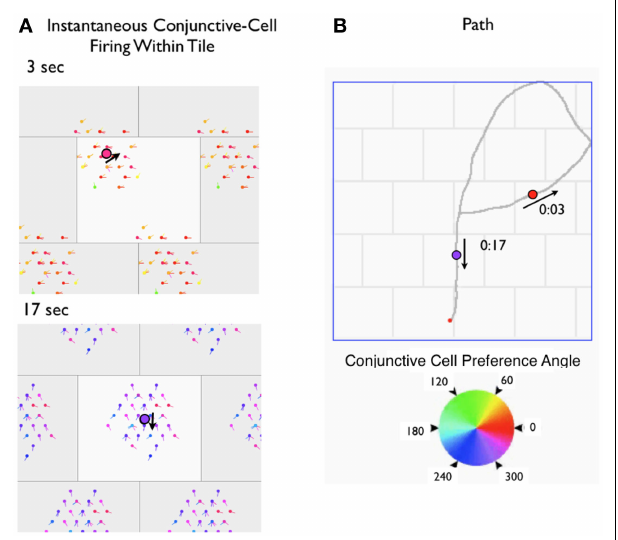
FIGURE 6 | (A) Video frames from a movie depicting the firing of conjunctive cells in a module during a 20s path through a rectangular chamber. (B) The 20-s path is depicted on the right. In (A) , the rigid module is depicted as a rectangular tile, with each cell’s phase mapped in the surface. A virtual neuron that has fired within the previous 200ms is depicted with others invisible. Additionally, the color (and “nose”) of the colored circle indicates the directional preference of a cell that fired.The black large circle is the virtual rat’s location at the mid-point of the 200ms sample. Gray boxes surrounding the central tile are half-replicas of the central tile.The three things to note are (1) the firing of cells is represented by a circular cluster, centered on the rat’s location; (2) for conjunctive cells, a subset of head angles will fire together; and (3) the firing of the cells in a rigid module can only signal the rat’s location and head orientation within the module.